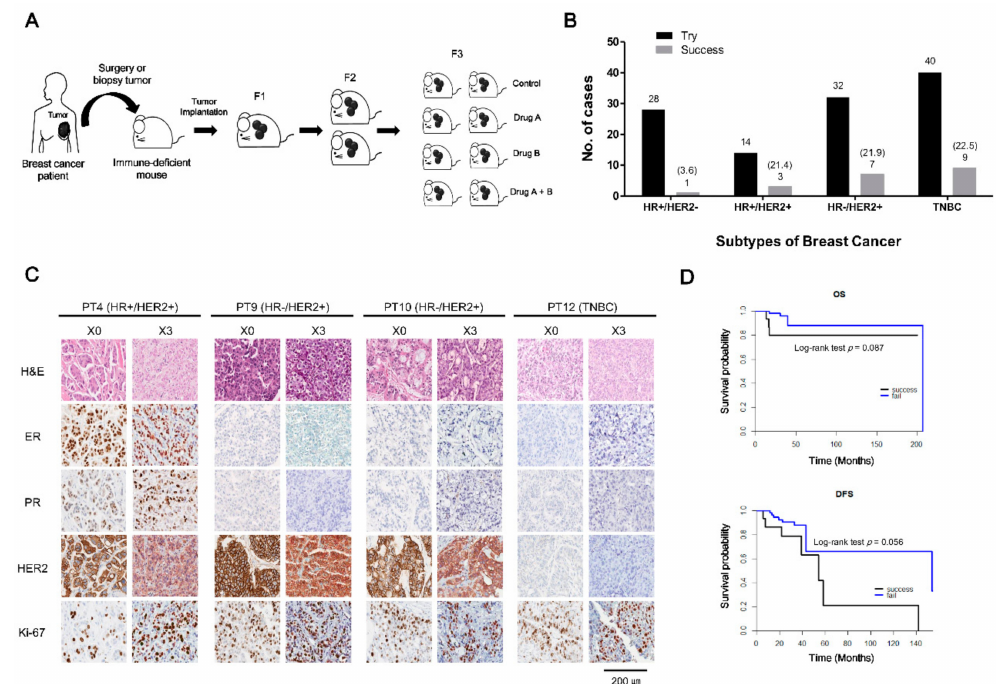
Figure 1. Establishment of patient-derived xenograft (PDX) models from di ff erent molecular subtypes of breast cancer. ( A ) Scheme of breast cancer PDX establishment and drug treatment. Surgical or biopsy tumor samples from breast cancer patients were implanted into the mammary fat pads of immunodeficient mice. Following growth of the tumor in passage 1 (F1), tumor fragments were serially transferred from mouse to mouse. In drug-response tests, PDXs were treated orally or intraperitoneally with drug A, B, or their combination. Drug e ffi cacy was assessed by monitoring tumor growth, validating histological features, and determining expression of target proteins. ( B ) PDX engraftment patterns according to breast cancer subtype. The number of PDX implantation trials and successes according to breast cancer subtype in samples obtained at the National Cancer Center, Korea, between July 2014 and September 2017. Success rates of PDX engraftment according to molecular subtype are shown in parentheses. The PDX engraftment rate for HR − / HER2 + , HR + / HER2 + and TNBC subtypes was relatively high (~21%) compared with that of the HR + / HER2 − subtype. ( C ) Comparison of histological features between representative patients’ original tumors and the corresponding PDX tumors. Four representative patients’ xenograft tumors showing retention of the same morphological features (H&E staining) and ER, PR, HER2 and Ki-67 biomarker status as the original tumors. Patient samples are shown in the left column; corresponding xenograft results are depicted in the right column. Scale bar, 200 µ m. ( D ) Overall survival (OS) and disease-free survival (DFS) of breast cancer patients according to PDX engraftment status. OS and DFS were analyzed using Kaplan–Meier plots and the log-rank test. Tumors from patients with poor OS ( p = 0.087) and DFS ( p = 0.056) showed a good engraftment